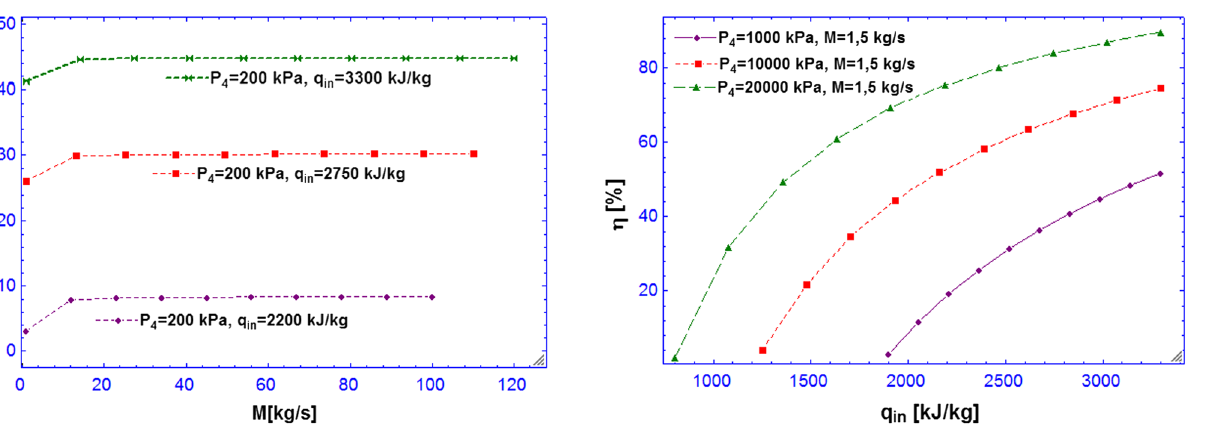
Fig. 8 Efficiency of Rankine cycle versus mass flow rate of the reverse osmosis at different thermal heat levels and constant pressure